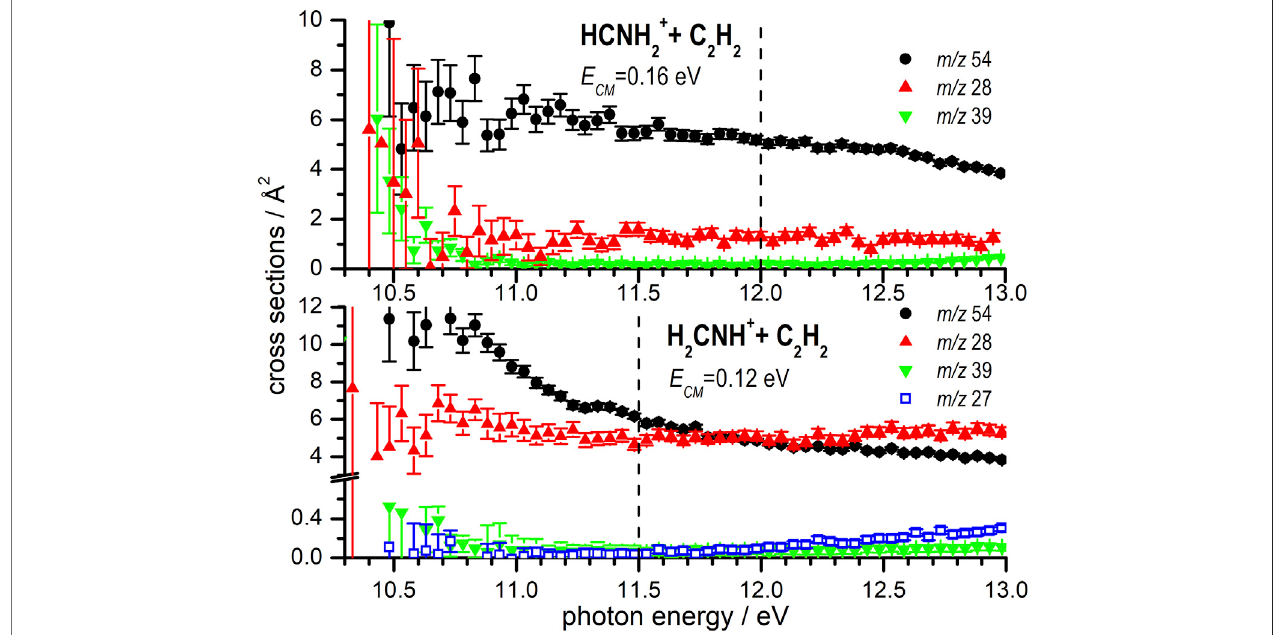
FIGURE 2 | Reactive cross sections as a function of E phot for the reaction of HCNH 2+ (cid:129) (top) and H 2 CNH + (cid:129) (bottom) with C 2 H 2 . The experimental AEs of parent ions at m / z 29fromboth precursors areat E phot (cid:2) 10.2 ± 0.1 eV (outside the x axis range).Collisionenergiesare fi xedat E CM (cid:2) 0.16 eV (top) and 0.12 eV (bottom) .The vertical dashed lines indicate the photon energies at which data have been collected as a function of E CM (see Figure 4 ).